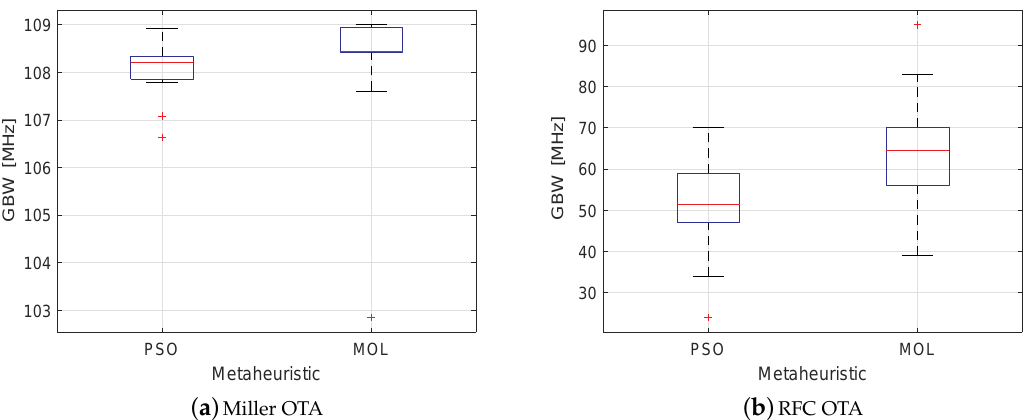
Figure 6. Box plots of the behavior of the best feasible solutions applying PSO and MOL in the optimal sizing of the OTA Miller and